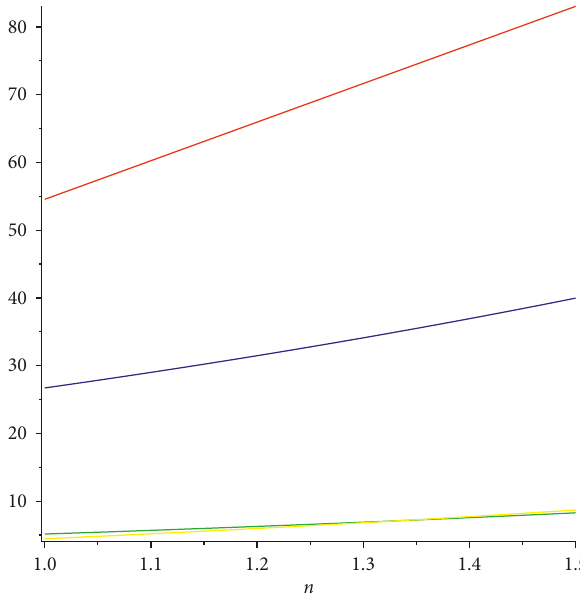
Figure 15: IRL of D